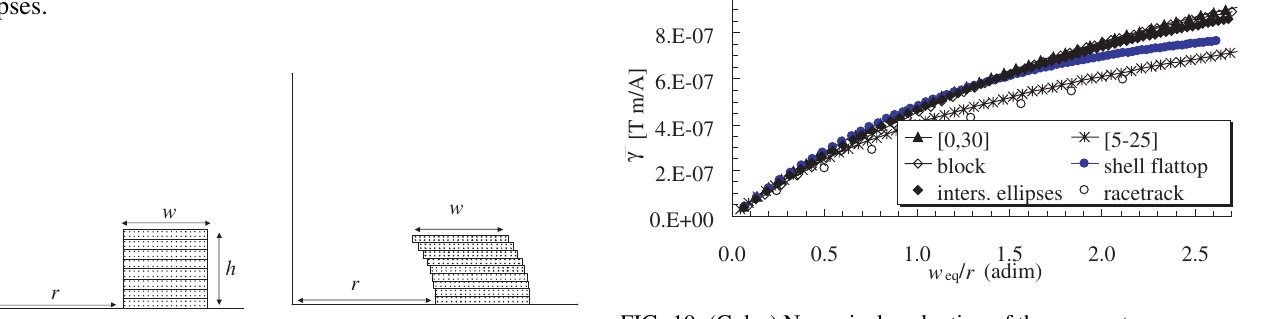
FIG. 17. The block (left) and the shell flattop (right) coil layouts (one eight of the whole cross section shown in the